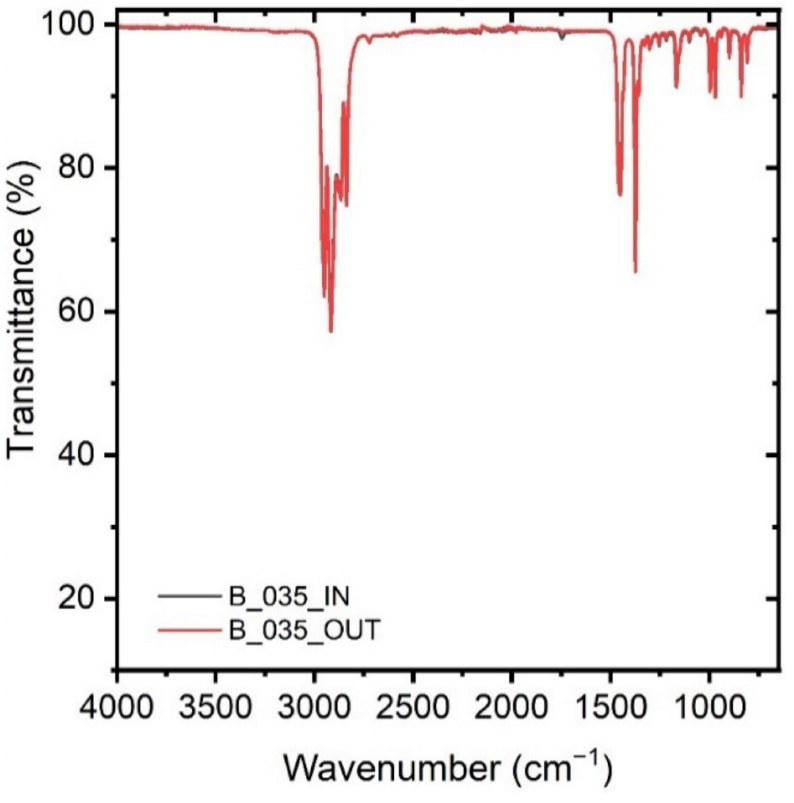
Figure 3. FTIR ATR spectra of a PP sample from the inner side (grey curve) and from the outer side (red curve). Table 4. FTIR ATR characteristic bands of polypropylene and their assignment